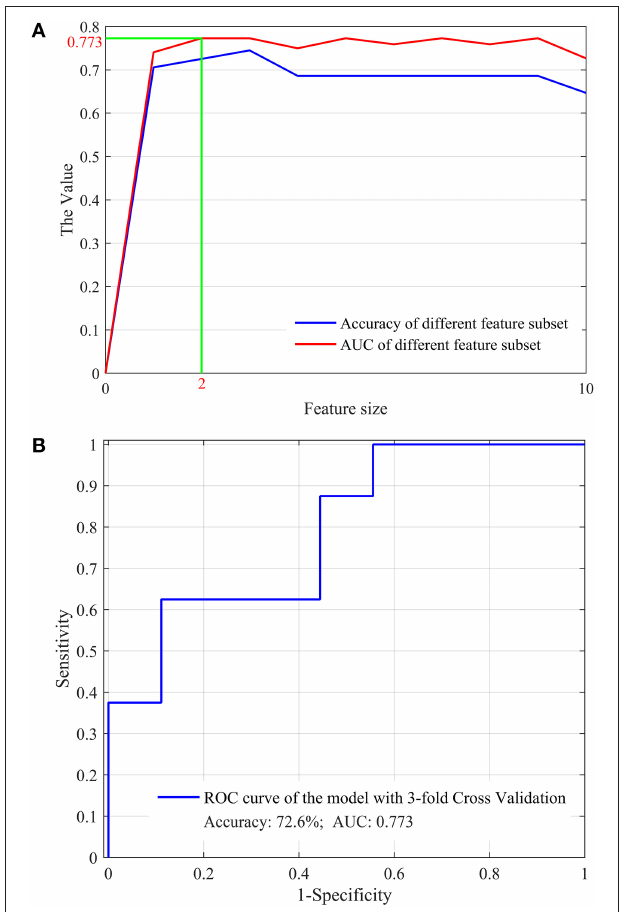
FIGURE 2 | The optimal feature subset selected from the significant radiomics features (A) and the overall performance (B) for the prediction of the re-positive cases.